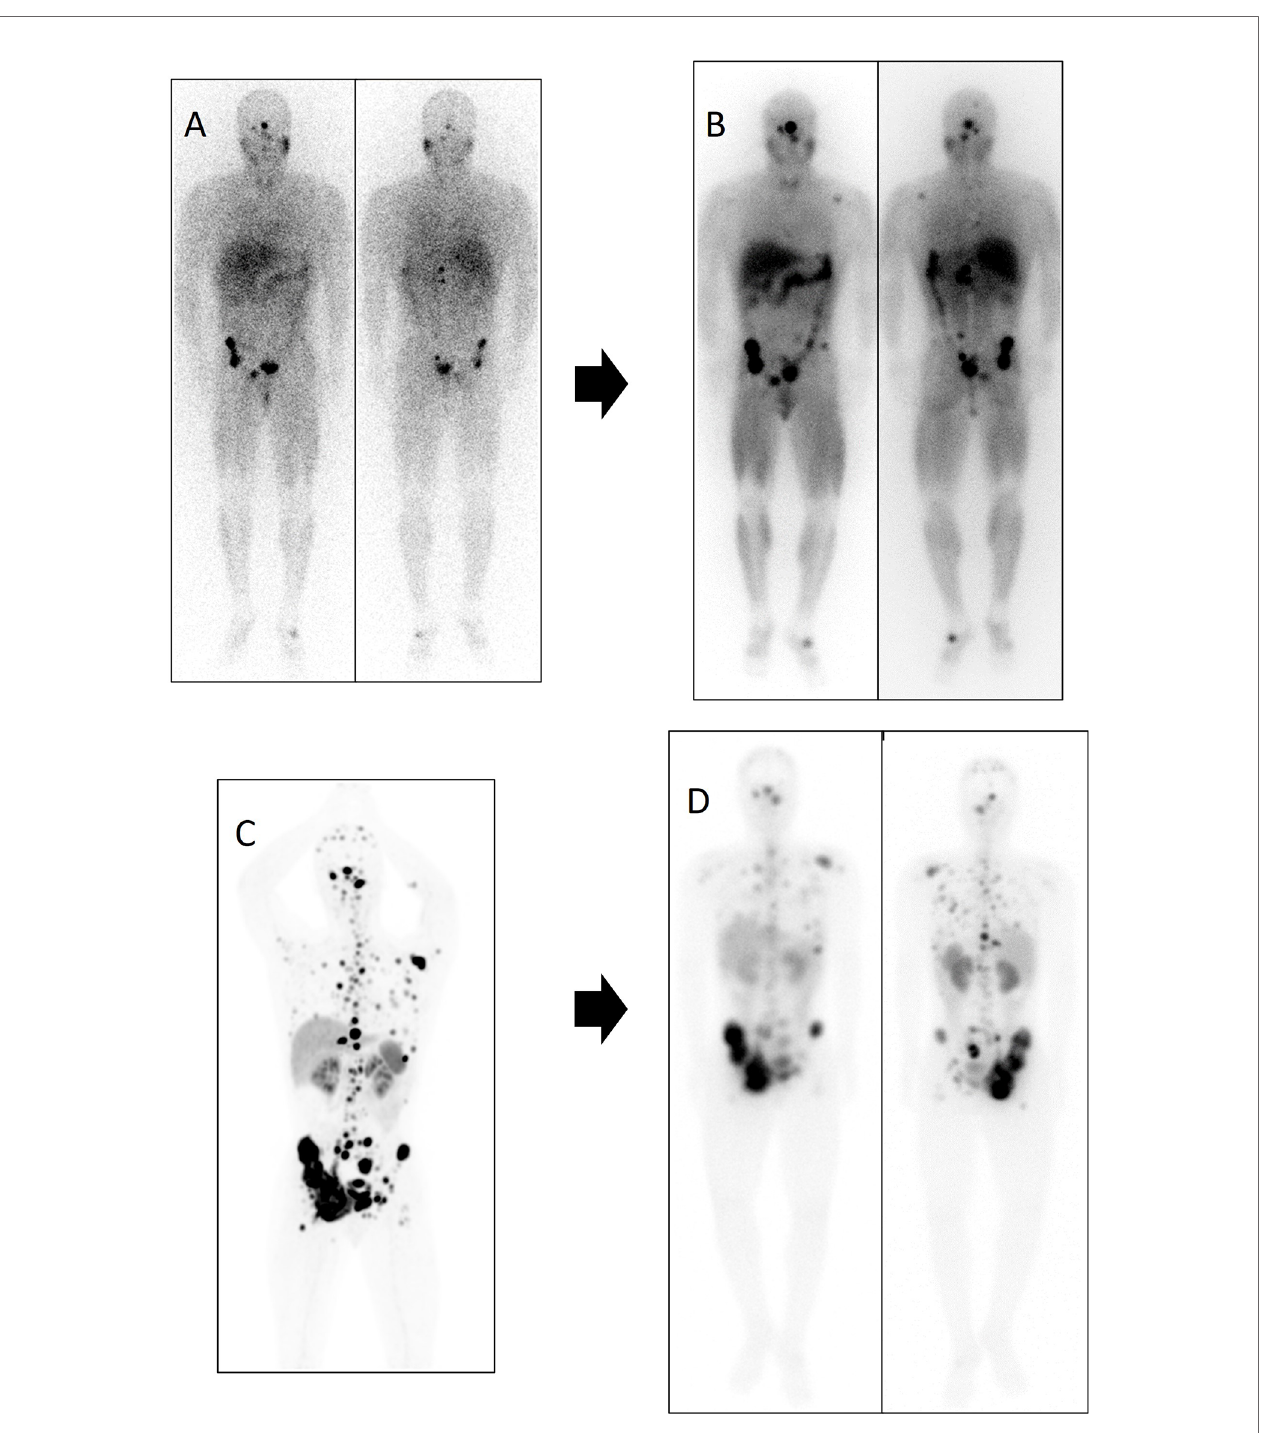
FIGURE 8 | Patient number 5 in the [ 131 I]MIBG table was treated fi rst with [ 131 I]MIBG and subsequently with PRRT. After 6 months of disease stability with [ 131 I] MIBG, lung, lymph node, and the bone disease progressed. Subsequently, the patient received treatment with [ 177 Lu]Lu-DOTA-TATE, reaching disease stability of 10 months. Diagnostic functional imaging studies and post-therapy distribution scans of both therapies are shown. (A) Diagnostic scan with [ 123 I]MIBG in anterior and posterior planar projection. (B) Distribution scan after treatment with 7.4 GBq of [ 131 I]MIBG in anterior and posterior planar projection. (C) 68 Ga-DOTA-SSA PET/ CT maximum intensity projection (MIP). (D) Distribution scan after treatment with 8.1 GBq of [ 177 Lu]Lu-DOTA-TATE in anterior and posterior planar